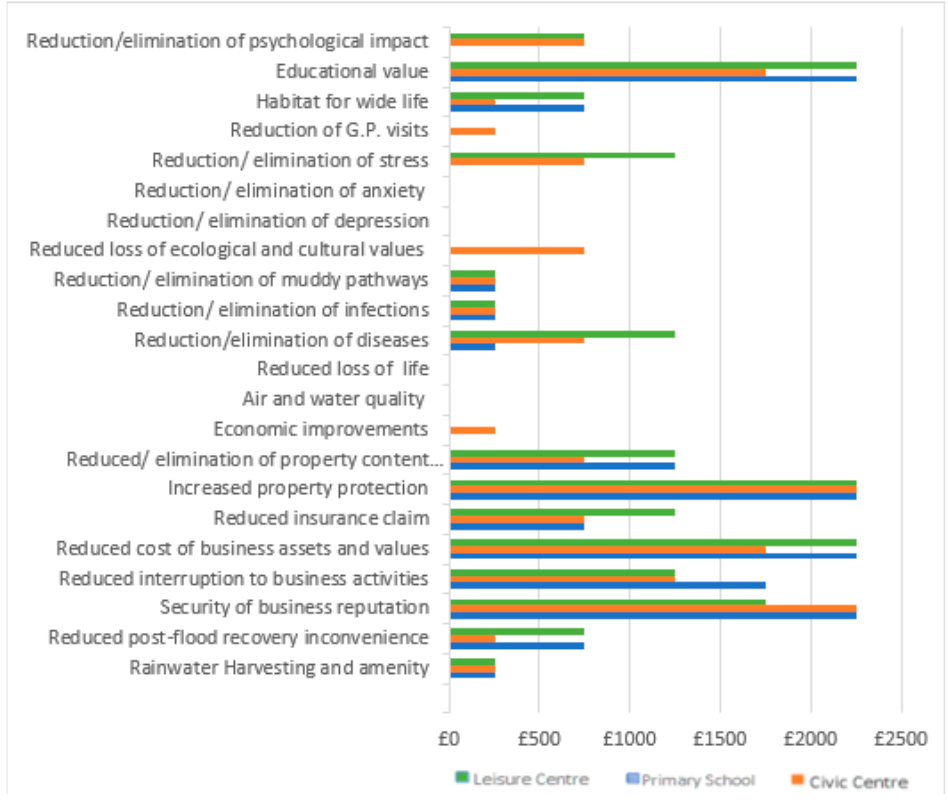
Figure 1. WTP Value of benefits across the